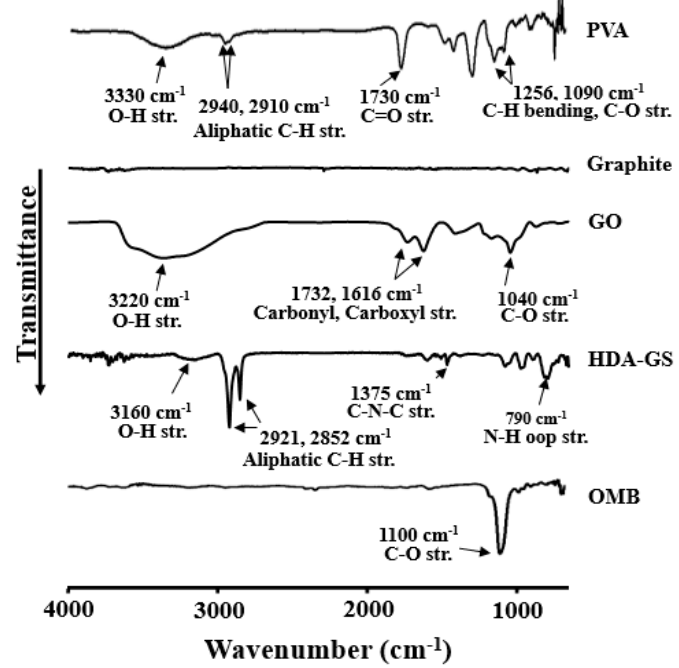
Figure 1. FT-IR spectra of PVA, graphite, and nanofillers.